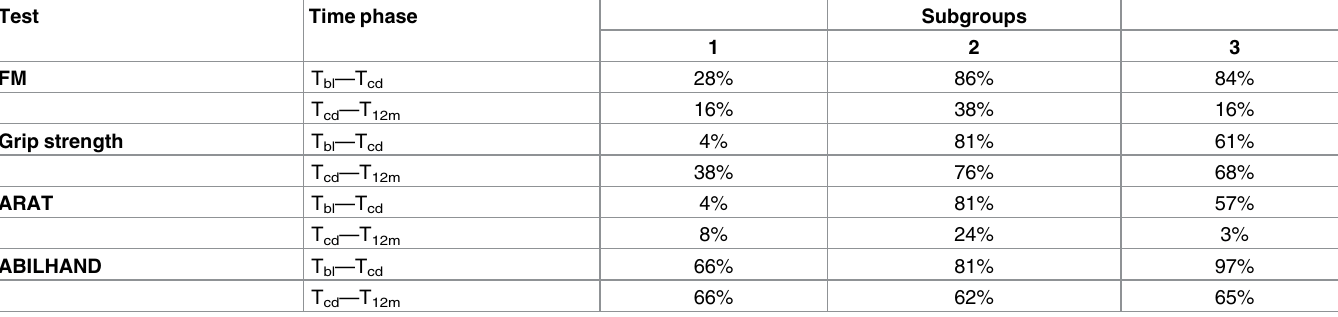
Table 4. Number of patients whose outcome scores exceeded the MCID thresholds, expressedas the percentage of the total number of persons within a subgroup, for FM, grip strength, ARAT and